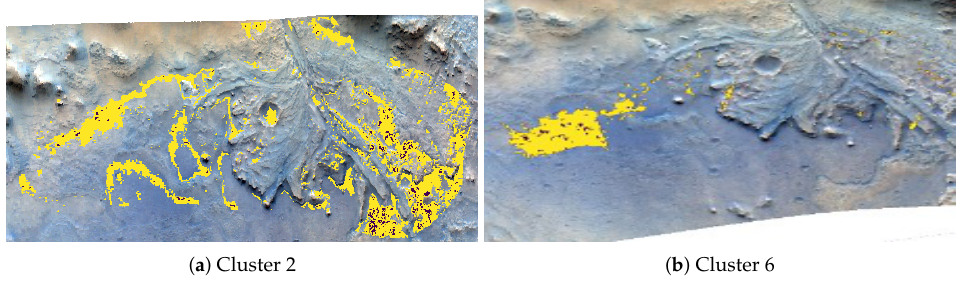
Figure 8. The two novel classes identified by the UMAP+k-Means and pictured as an overlay of the true image of Jezero Crater. Left: cluster 2 embraces mainly the unclassified area of expert map (cf. Figure 4a). Right: cluster 6 indicates a new mineralogy